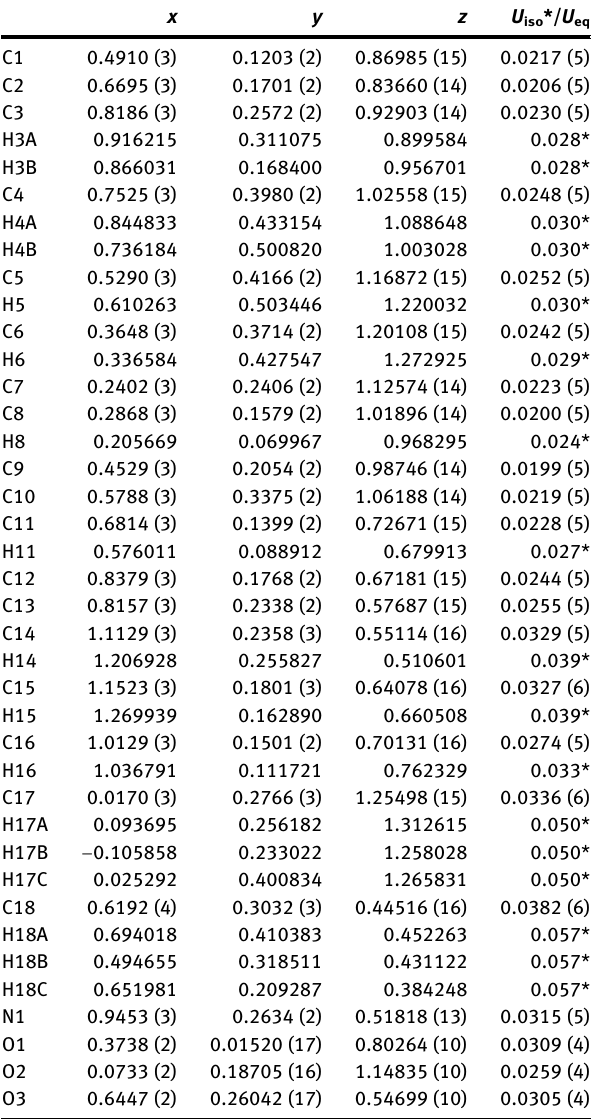
Table  : Fractional atomic coordinates and isotropic or equivalent isotropic displacement parameters (Å 